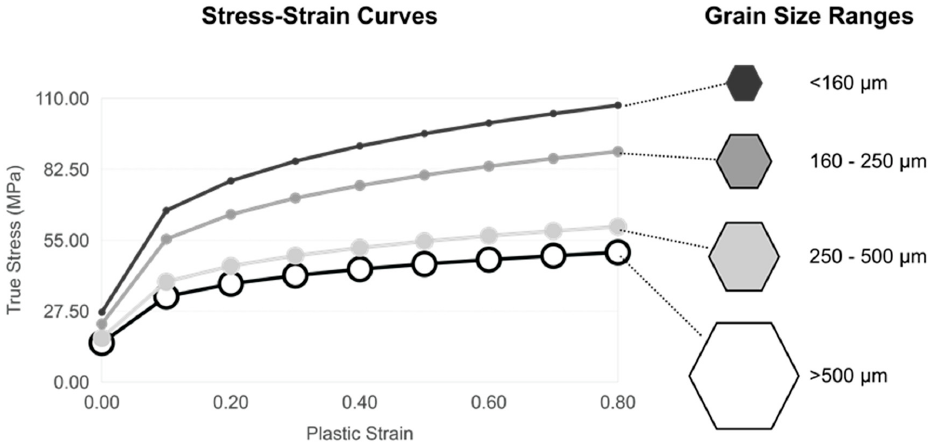
Figure 7. The estimated stress-strain curves of the considered grain sizes. Table 2. The material constants in the power-law model of the enlarged grains [37].